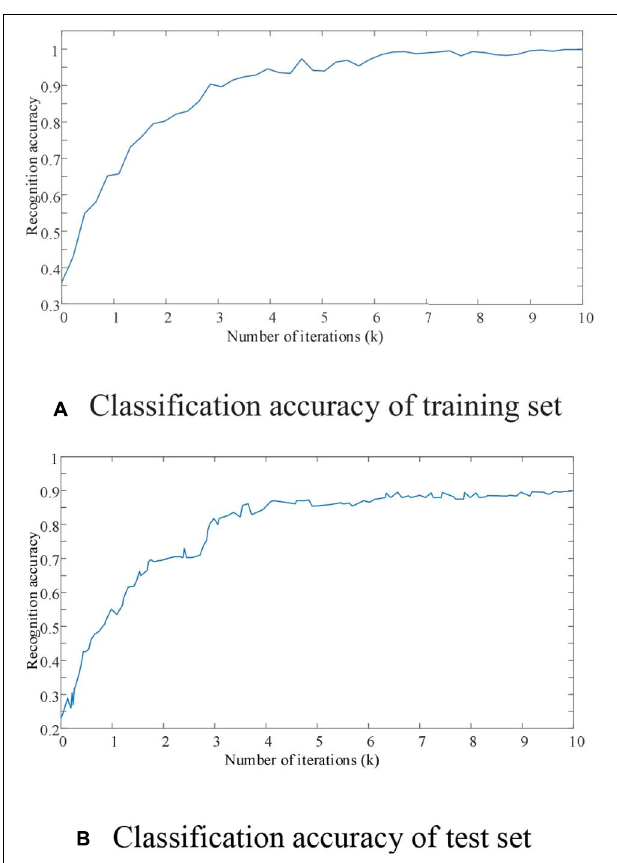
FIGURE 7 | The curve of recognition accuracy with the number of